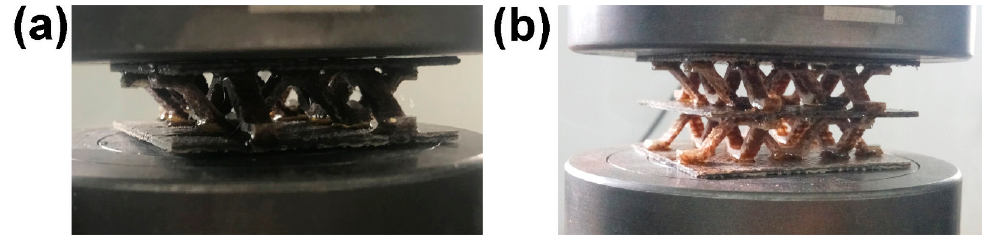
Figure 5. ( a ) Single-layer structure ( b ) Double-layer structure.